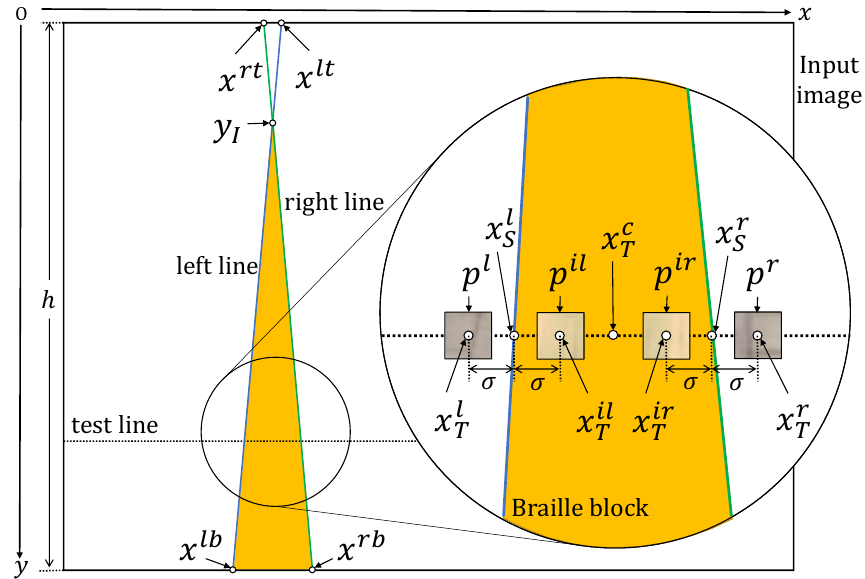
Figure 3. Notation of the variables used for calculating the objective